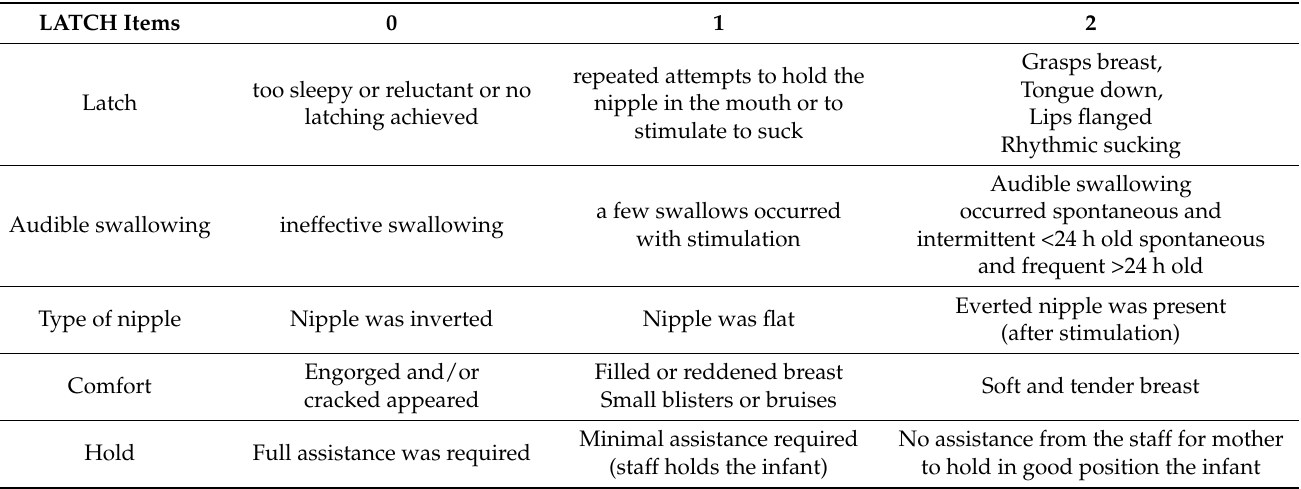
Table 2. Explanatory grid used for assessing breastfeeding technique with LATCH score among included patients at 24 and 48 h age after